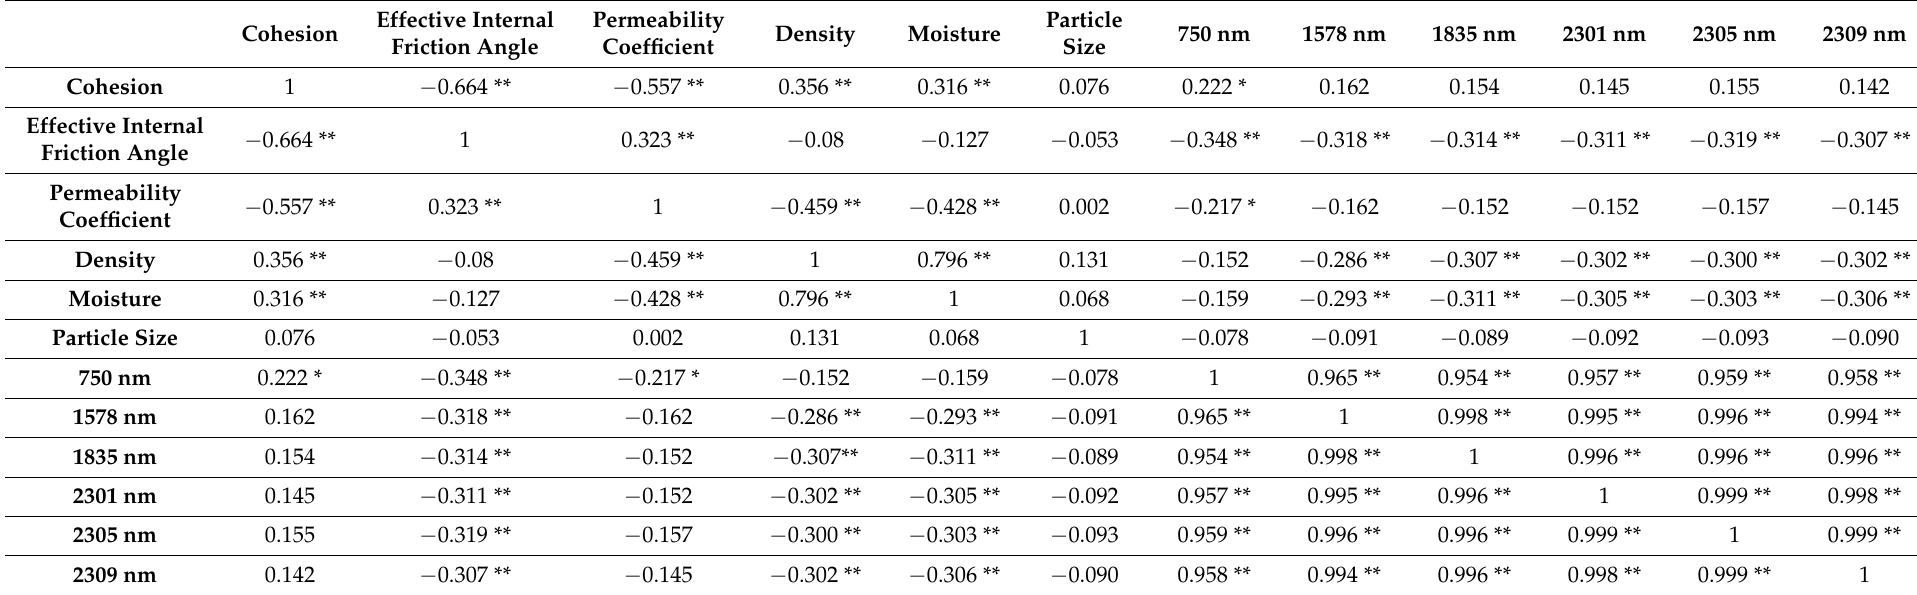
Table 3. Correlation coefficients between parameters and sensitive